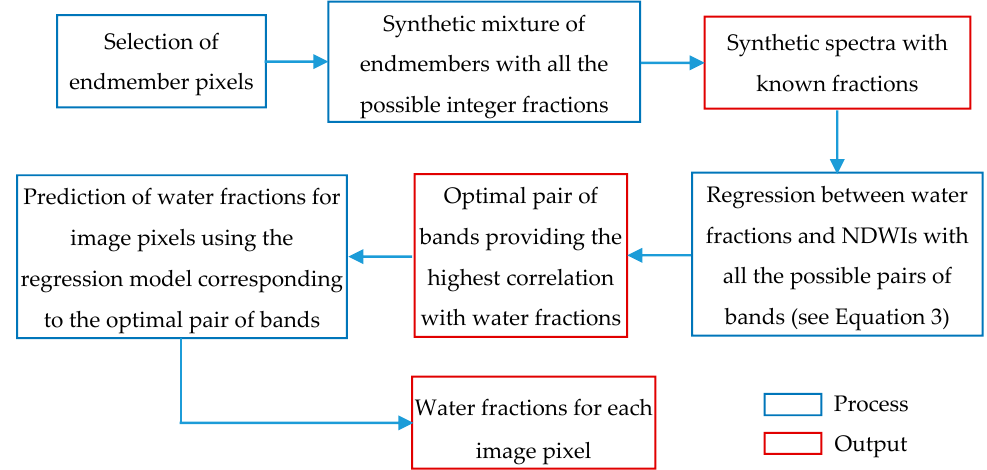
Figure 5. The step-by-step procedure for implementation of the proposed optimal band analysis for the normalized difference water index (OBA-NDWI) for the estimation of water fractions.